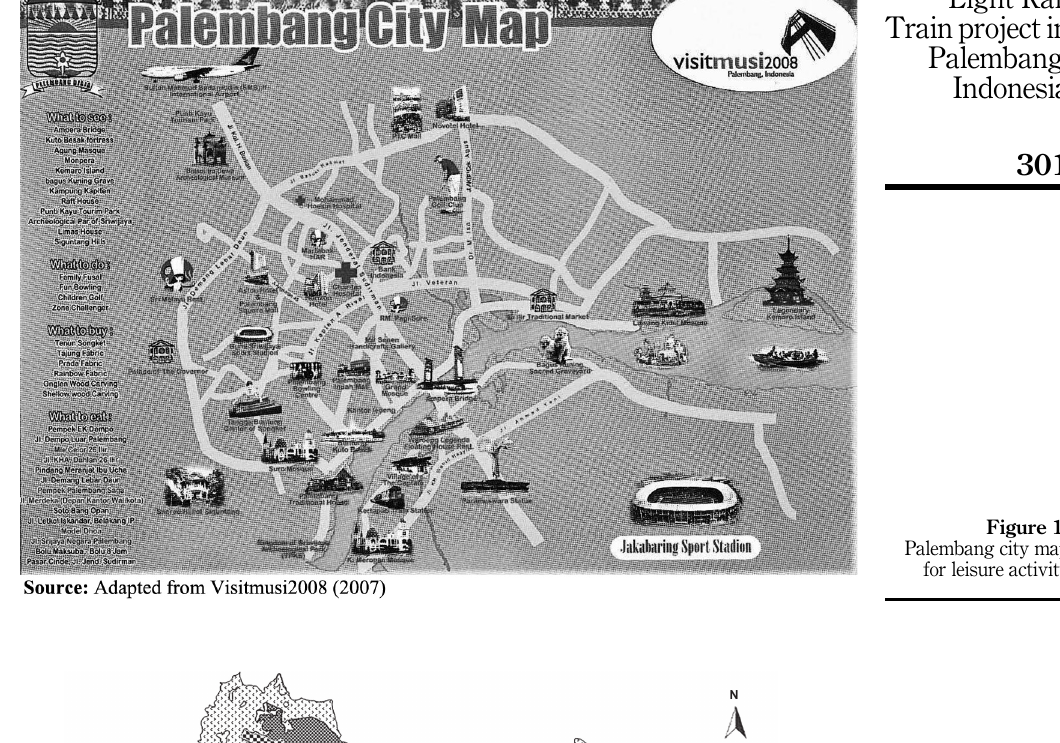
Figure 1. Palembang city map for leisure activity